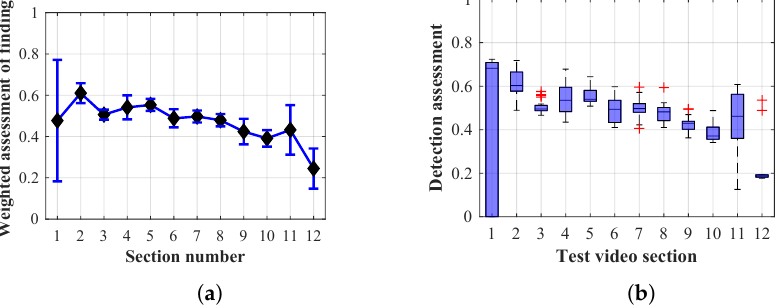
Figure 29. ResultsofMethod1.1withalifespanof40frames. ( a )theweightedaverageratingwiththeaverage mean absolute error of the weighted rating and ( b ) boxplots of the distribution of the statistical sets of the results of the individual sections evaluated indicating: minimum, 1st quartile, median, 3rd quartile,